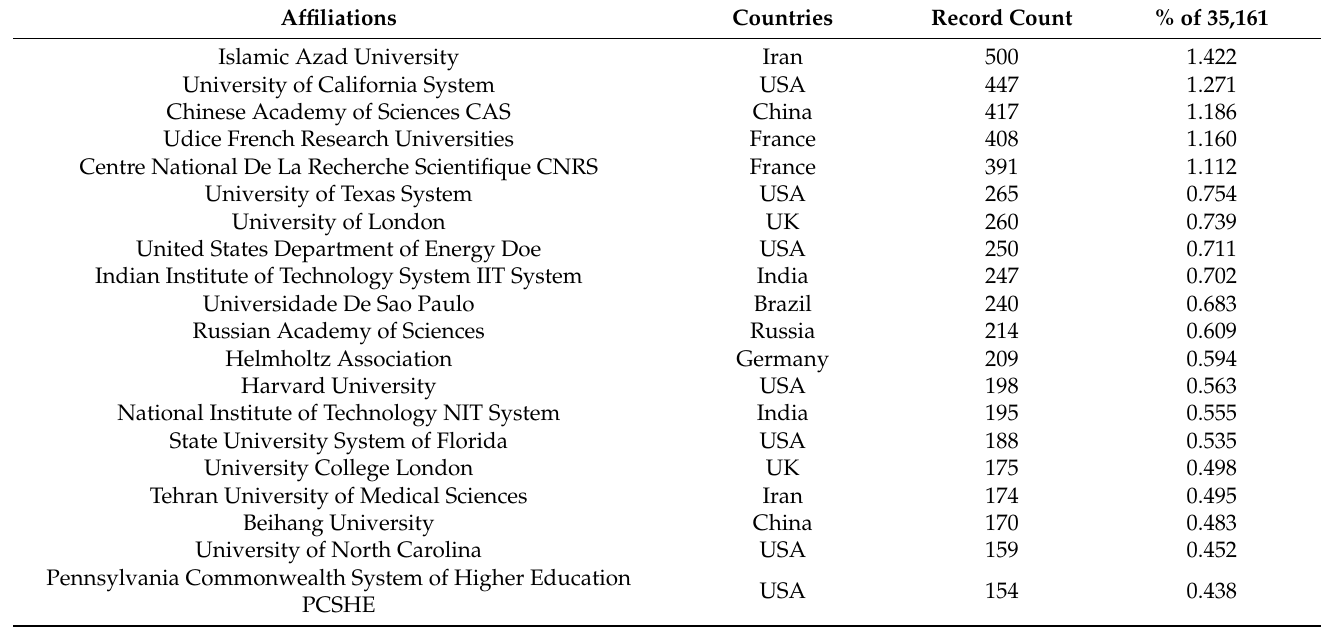
Table 9. Top 20 Institutions/Organizations based on the number of publications for the years (2016–2018).